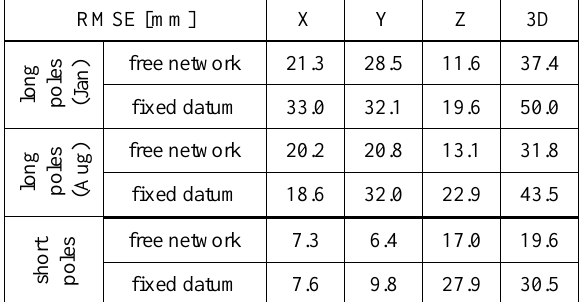
Tab.4: Root Mean Square Errors (RMSE) in GCPs of the